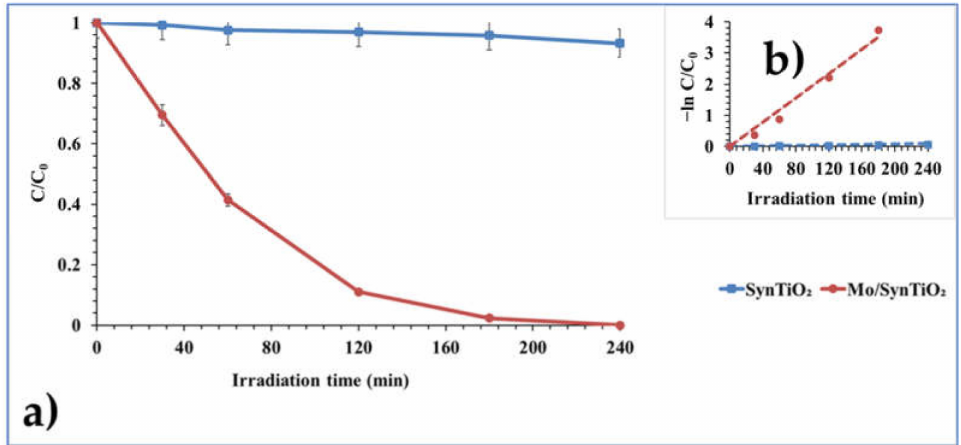
Figure 7. ( a ) Preliminary photocatalytic test performance of SynTiO 2 (blue line) and Mo/SynTiO 2 (red line); and ( b ) their corresponding photocatalytic degradation rate constant (k) under test conditions of 1 g/L catalyst dosage, 5 mg/L initial CBZ concentration, initial natural (unmodified) pH 5.84, and 365 nm UV